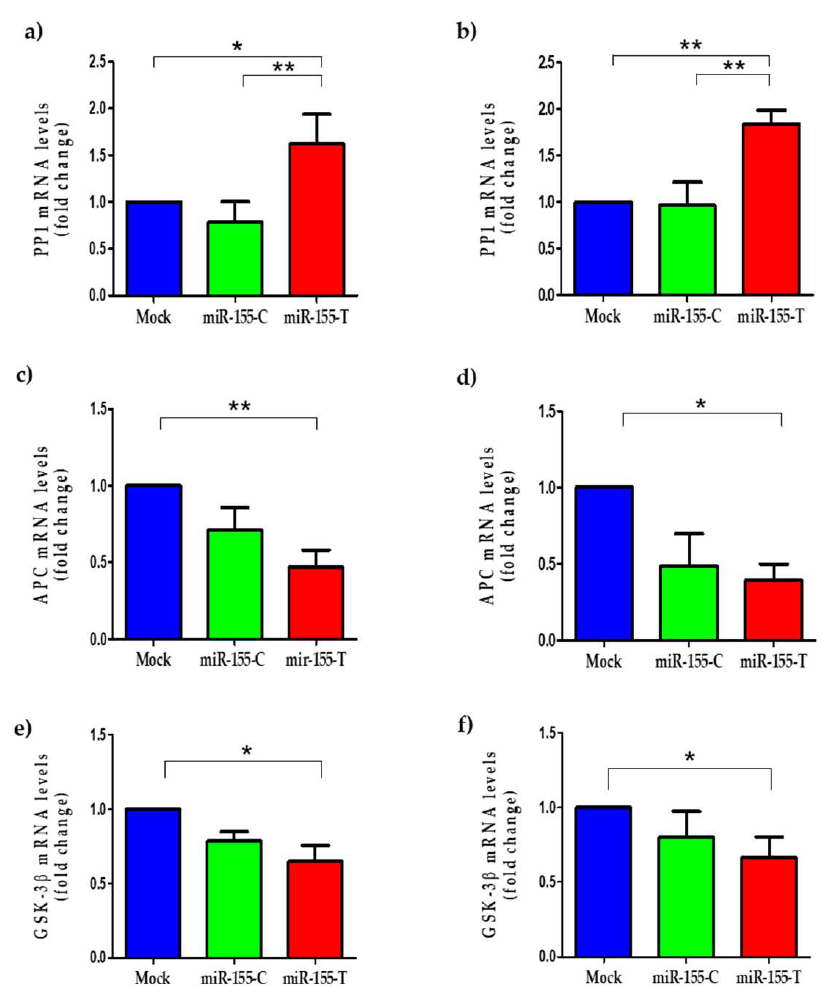
Figure 6. Regulation of canonical Wnt pathway-related elements by the miR-155-T allele. MDA-MB-231 ( a , c , e ) and MCF-7 ( b , d , f ) BC cell lines were transfected with miR-155-C, miR-155-T, or mock vectors as indicated and grown for 24 h in complete media. The graphs show the relative mRNA levels of PP1 ( a , b ), APC ( c , d ), and GSK-3 β ( e , f ). The levels of GAPDH mRNA were used as a reference. The plotted values indicate the average of three independent experiments ± SD. * p < 0.05; ** p < 0.01.